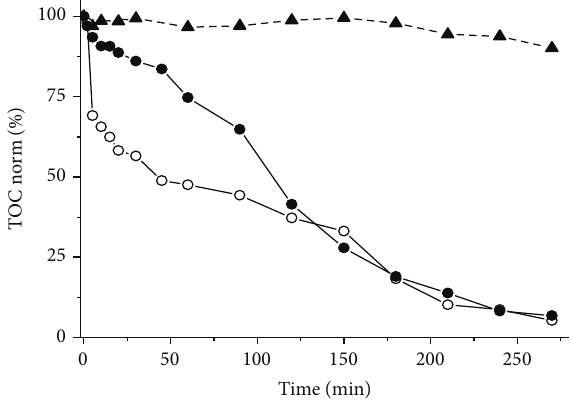
Figure 4: Mineralization curves (given as TOC%) of DCF (50mg/ mL) under UV-Vis irradiation in the presence of O 2 for ( 󳵳 ) Blank, ( I ) TiO 2 , and ( e ) TS in